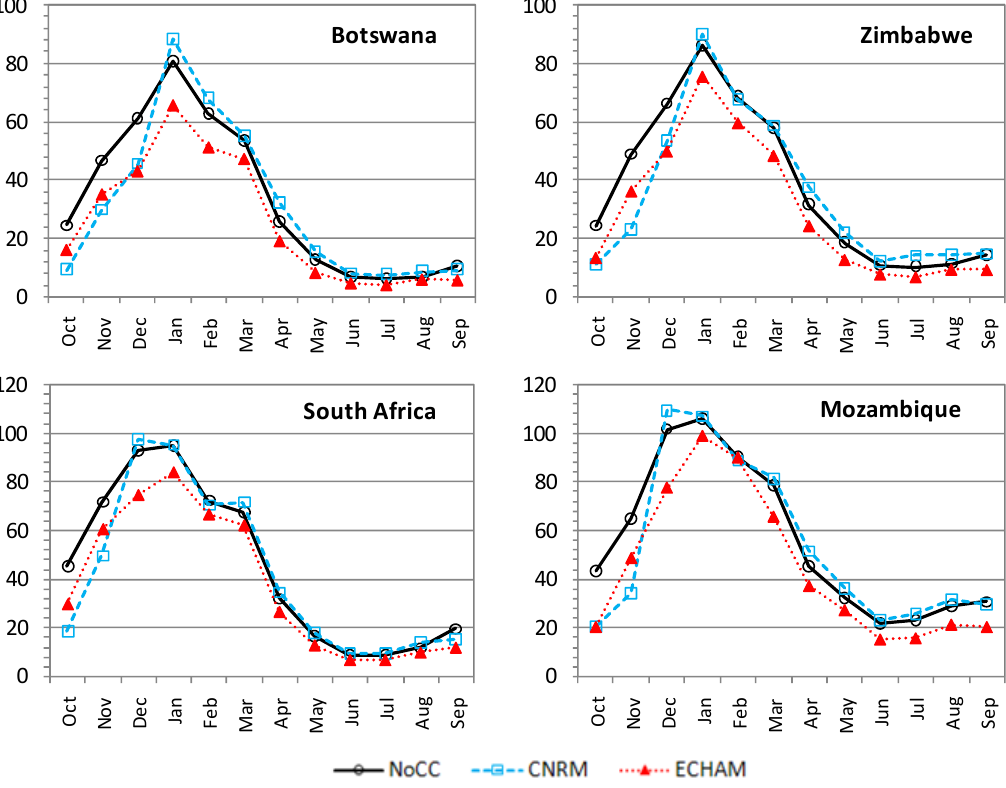
Figure 11. Simulated mean monthly actual evapotranspiration (mm) under the 1971–2000 climate baseline and climate change scenarios for 2050.